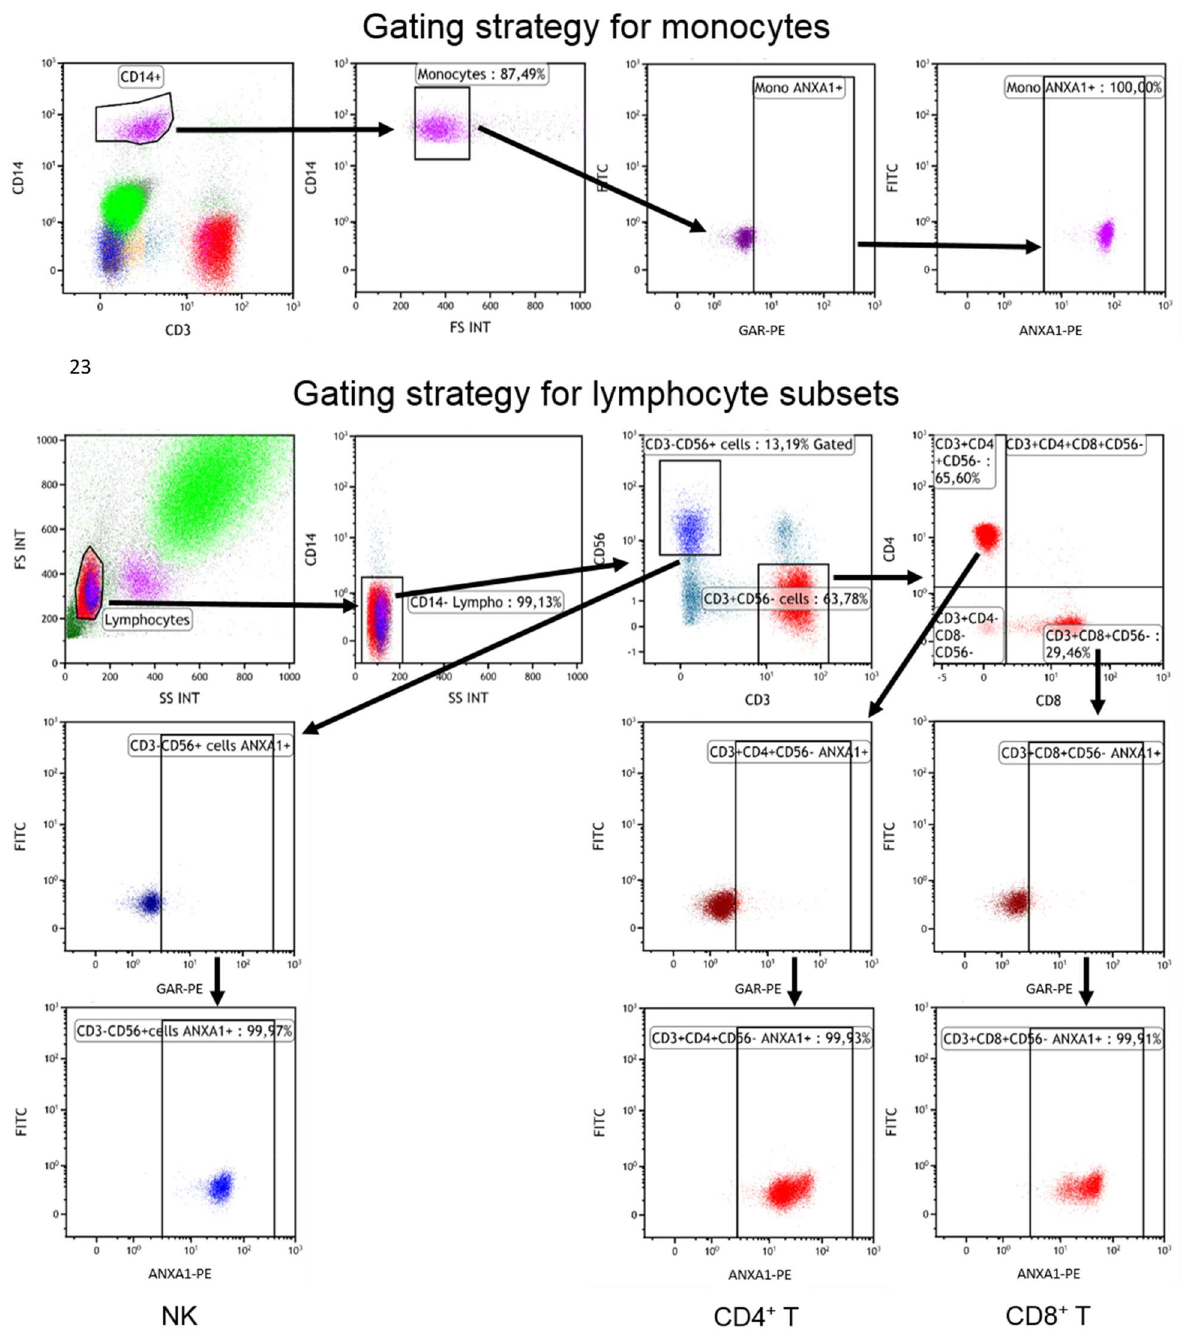
Fig 3. Representative examples of dot plots. The figure shows the gatingstrategy for total AnxA1. Monocytes were definedas CD3 - CD14 + and further checked for size basedon forward scatter (FS) before being plotted for expressionof secondarygoat anti-rabbit F(ab’) 2 (GAR)-PE. Lymphocytes were gated basedon FS and side scatter (SS). Due to decreasein cell size and granularityas a result of intracellular staining(most prominentlyseen when stained for GR expression), lymphocytes were also definedas CD14 - to avoid inclusionof monocytes in lymphocyte gate. From CD14 - lymphocytes, NK cells were definedas CD3 - CD56 + , and T cells as CD3 + CD56 - . T cells were subsequently plotted for CD4 and CD8. For each subpopulation(monocytes, NK cells, CD4 + T cells and CD8 + T cells), the gate for AnxA1/GR-alpha/GR-beta expressionwas set visuallyas close to the main negativepopulationas possiblein the sample containing only the secondary GAR-PE antibody. The same gate was then kept for the sample containingthe primary antibody.